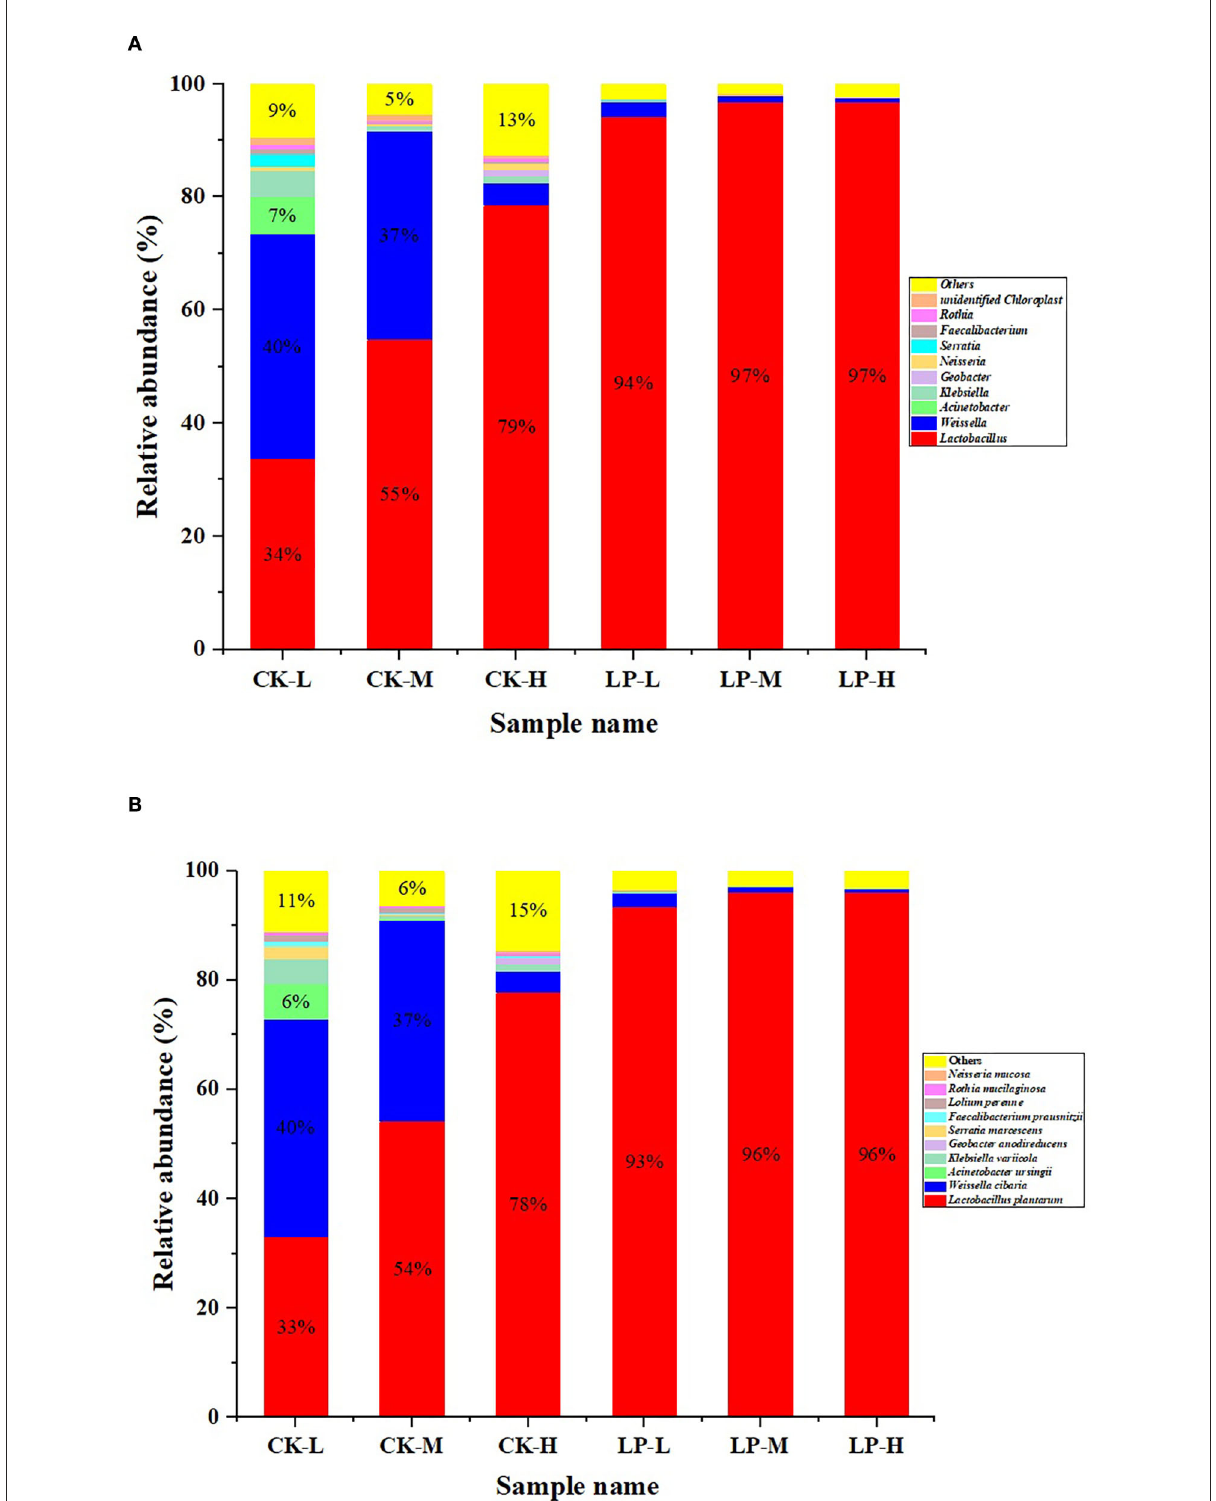
FIGURE3 The bacterial community of Lablab and sweet sorghum intercropped silages with or without LP at genus level (A) and species level (B) after fermentation. CK, sterile water; LP, Lactobacillus plantarum ; L, Lablab and sweet sorghum seed-sowing ratio of 1:1; M, Lablab and sweet sorghum seed-sowing ratio of 5:1; and H, Lablab and sweet sorghum seed-sowing ratio of